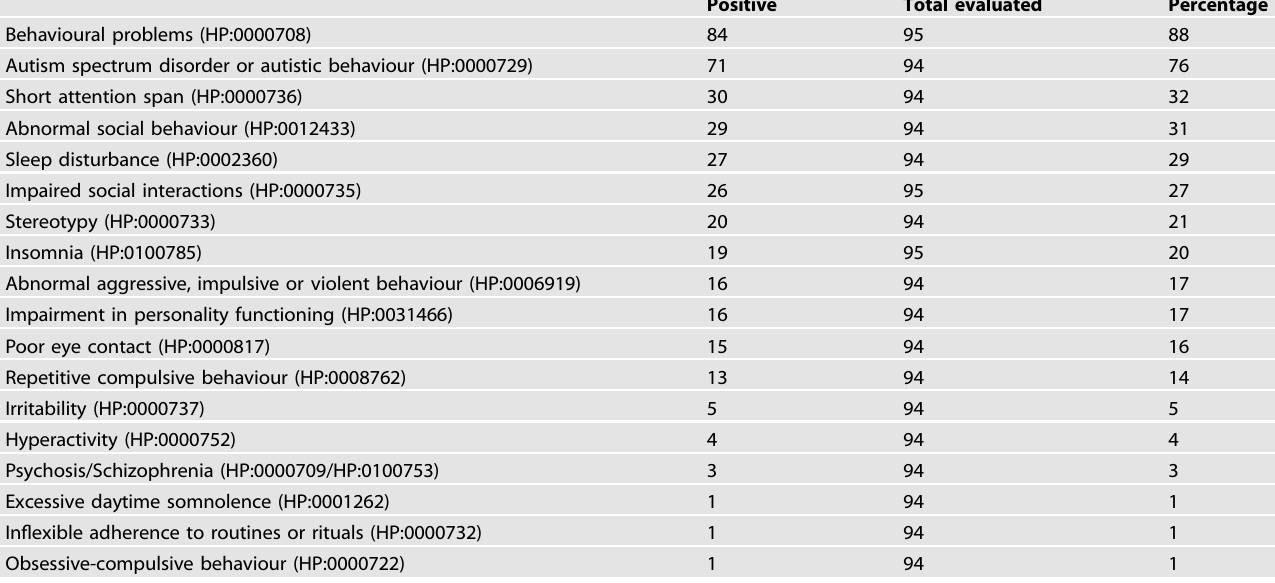
Table 2. Behavioural phenotype in individuals with a (likely) pathogenic variant in CHD8 .